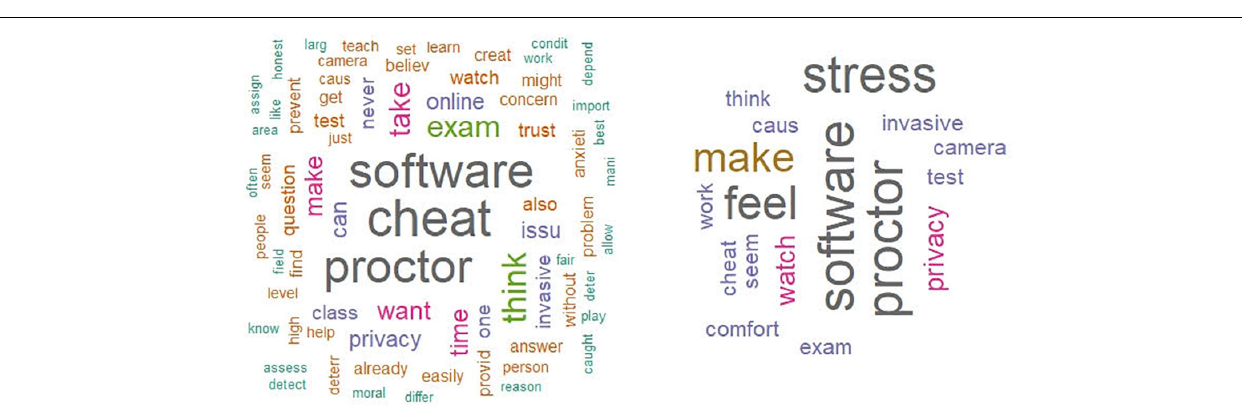
FIGURE 5 | Wordcloud of Faculty (left) and Student (right) comments about the use of proctoring software, with frequency of terms directly proportional to font